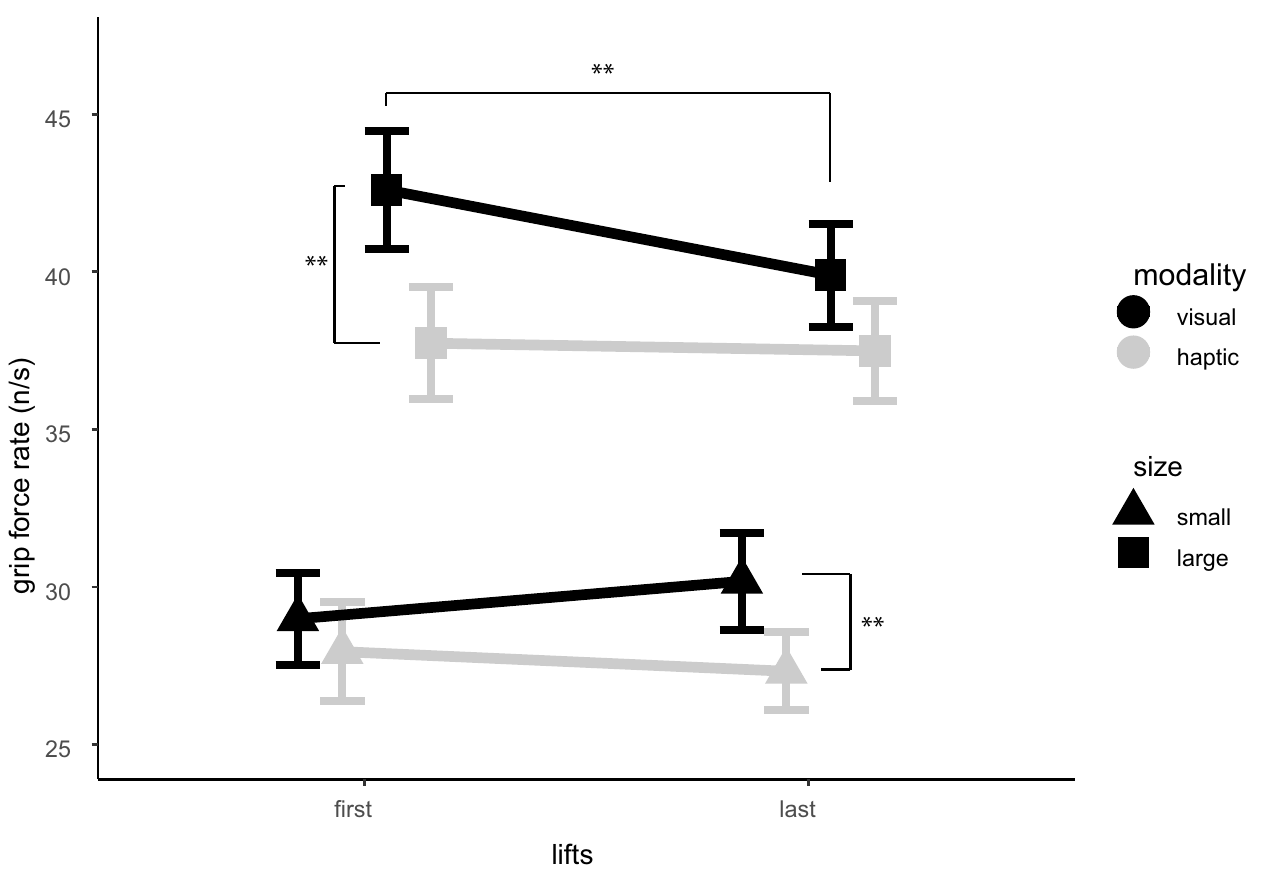
Fig 3. Condition � Size � Lift interaction. Participants show reduced grip force rate over lifts for the larger object in the visual condition.